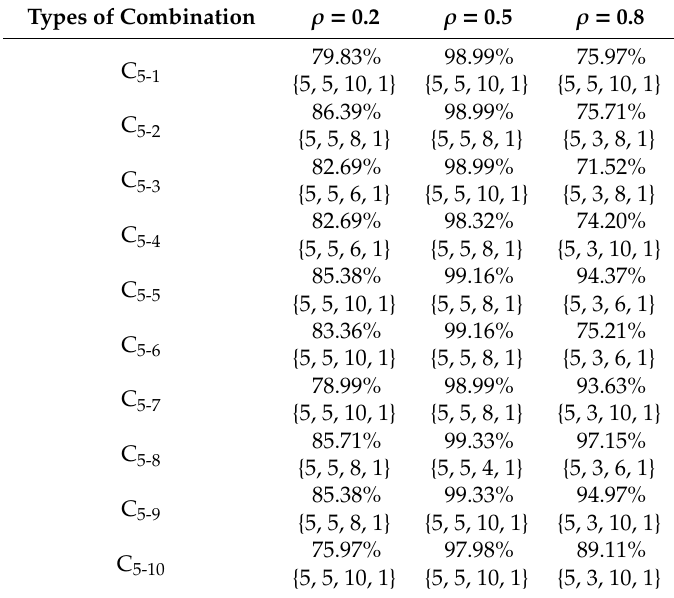
Table 2. TDNN identification results, accurate identification rate (AIR)- TDNN {TD ni , TD nd , TD nh , TD no }, for ten combinations of faults of a multivariate normal process (MNP 5